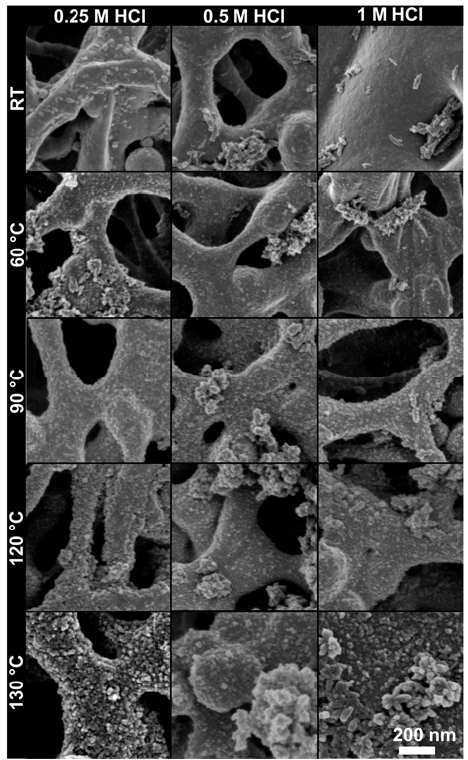
Figure 2. SEM (scanning electron microscopy) image of PES (polyethersulfone) membranes with TiO 2 nanoparticles synthesized at different temperatures (room temperature: RT, 60 ◦ C, 90 ◦ C, 120 ◦ C, and 130 ◦ C) and with different concentrations of HCl (0.25 M, 0.5 M, and 1